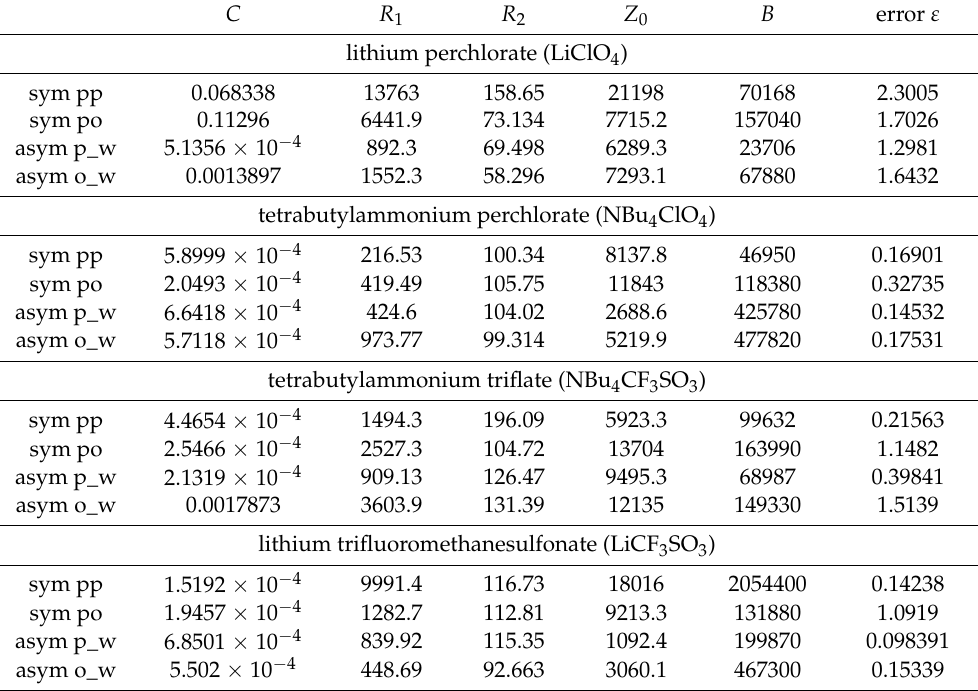
Table 3. Results of the estimation of the parameters of the model with the Warburg limited impedance.